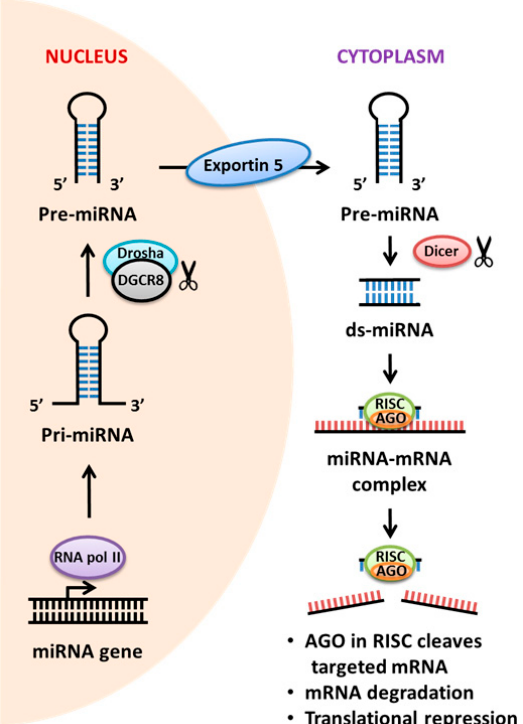
Figure 4. Mechanisms of actions of miRNAs. The miRNA gene is transcribed into a primary